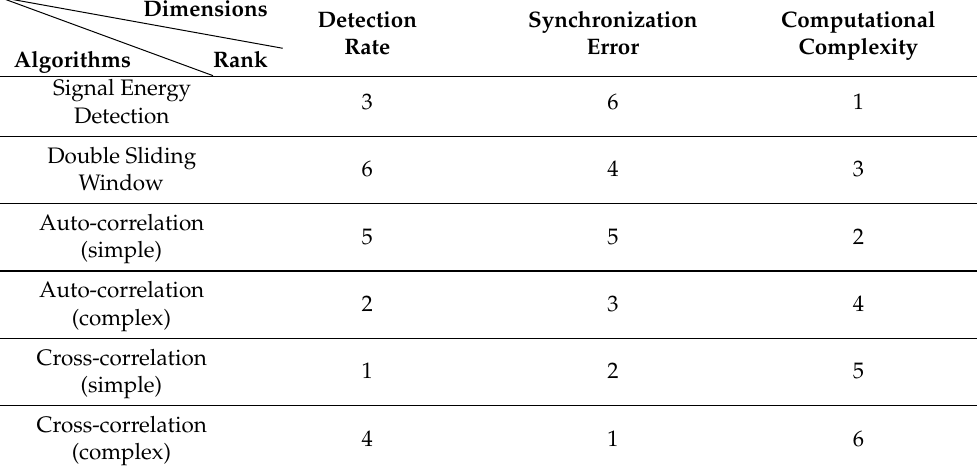
Table 3. Comparison of the four algorithms in three dimensions. For the two preamble-based algorithms, comparisons are also made with different decision rules. The values in the table represent the ranking of algorithms on that